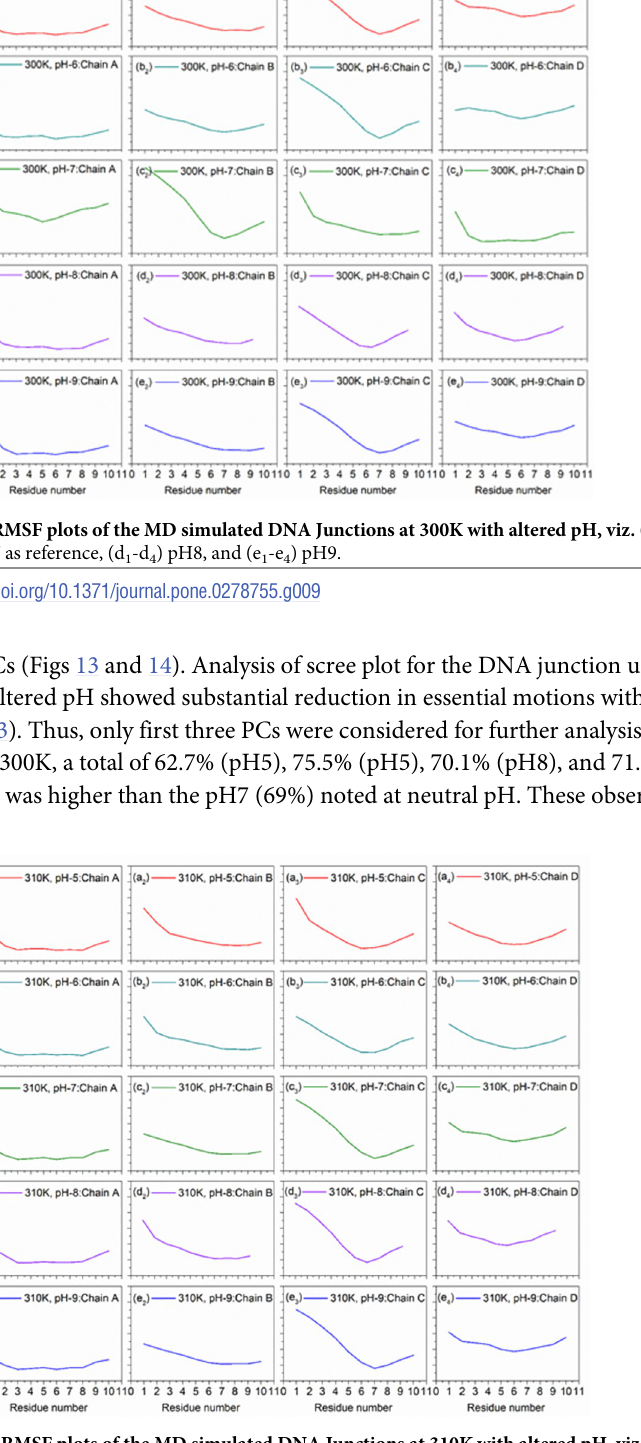
Fig 10. RMSF plots of the MD simulated DNA Junctions at 310K with altered pH, viz. (a 1 -a 4 ) pH5, (b 1 -b 4 ) pH6,